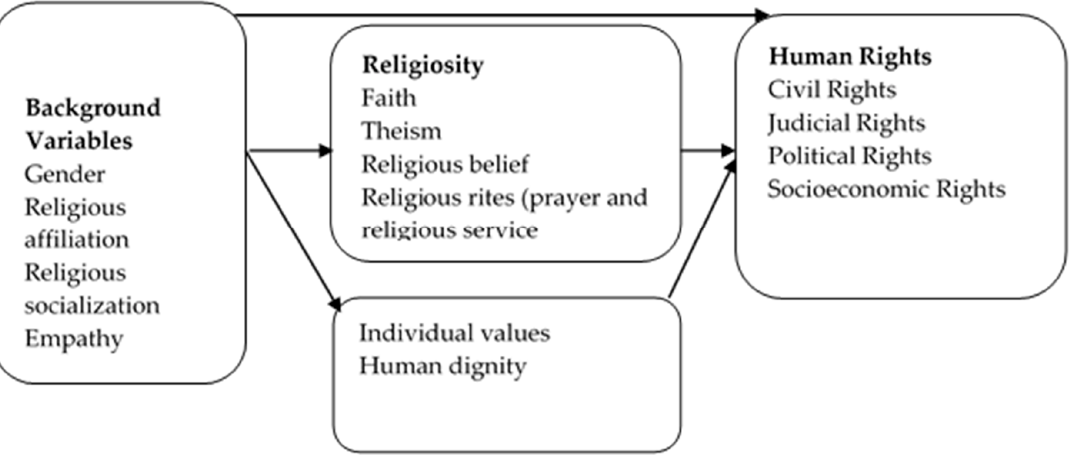
Figure 1. Conceptual model for research study.